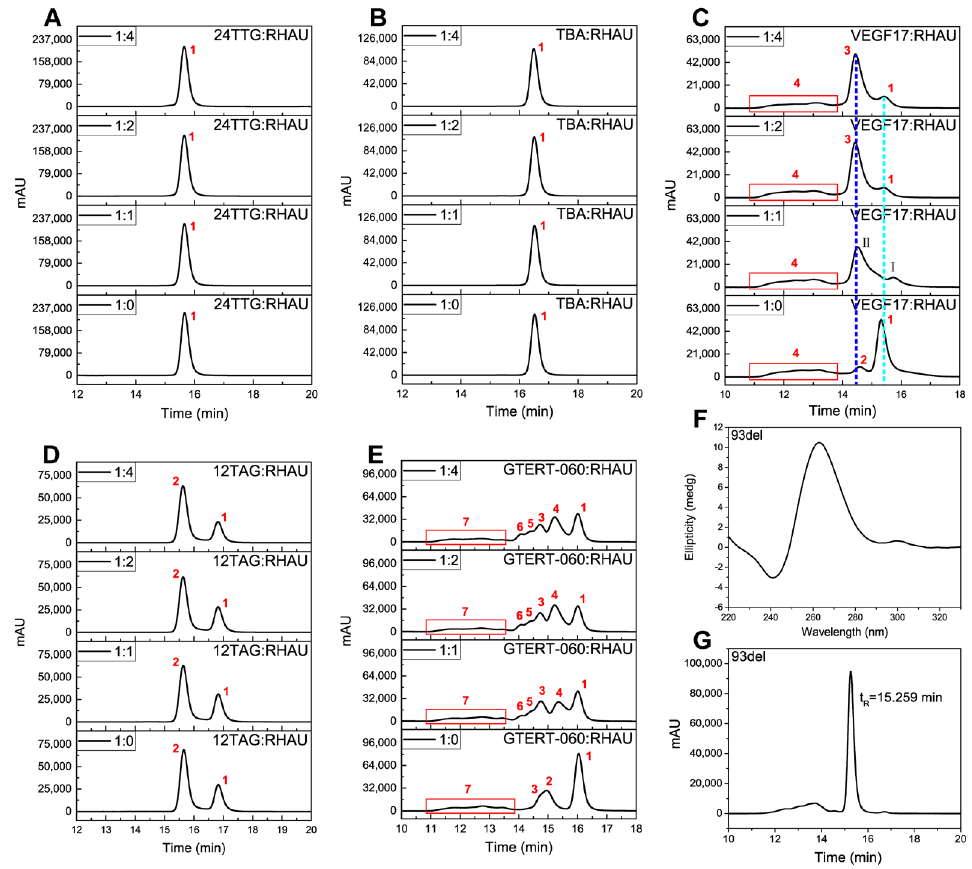
Figure 3. SEC chromatograms of G4s with RHAU in different molar ratios after 30 min incubation, and the CD spectrum and SEC chromatogram of 93del. ( A ) 24TTG, ( B ) TBA, ( C ) VEGF17, ( D ) 12TAG and ( E ) GTERT-060; ratios: 1:0, 1:1, 1:2 and 1:4. ( F ) CD spectrum and ( G ) SEC chromatogram of 93del dissolved in Tris-HCl buffer (5 mM Tris-HCl, 50 mM KCl, pH 7.4). Chromatograms were obtained under isocratic mode at the rate of 0.5 mL min − 1 on a TSKgel G2000SW XL column (7.8 × 300 mm i.d.) with 50 mM KH 2 PO 4 as mobile phase. The concentrations of G4s were 10 μM . The column temperature was maintained at 30 °C and the detection wavelength was 260 nm. The chromatographic peaks of each G4 numbered in 1–7 corresponded to substances as described in Table 1. The light blue dashed line was used to distinguish the retention times between peak 1 and peak I, and the dark blue dashed line was used to distinguish the retention times between peak 2, peak 3 and peak II of VEGF17.